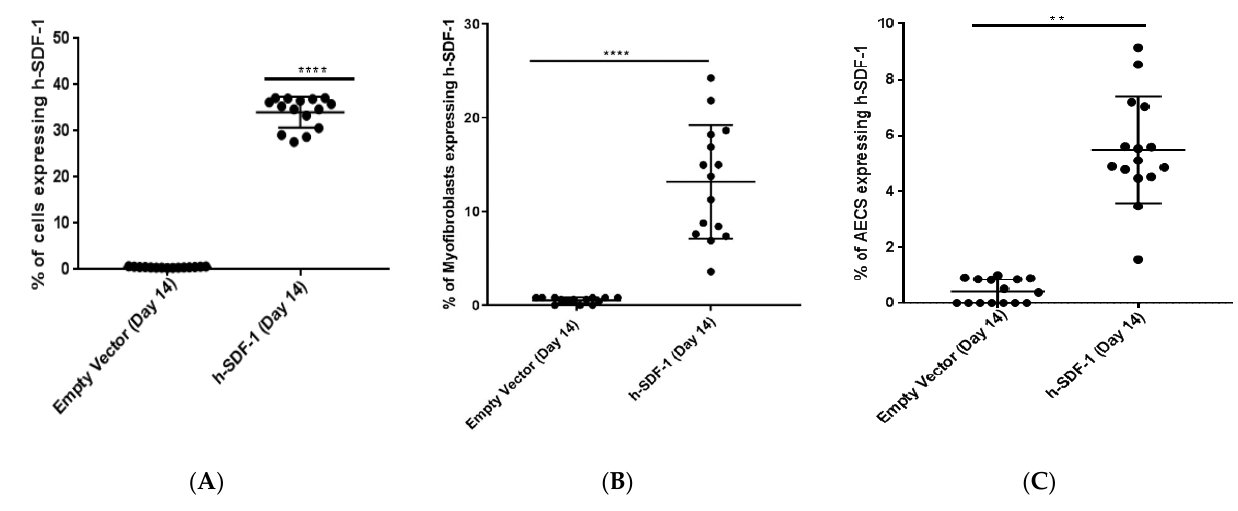
Figure 1. Efficiency of electroporation-mediated h-SDF-1 β gene transfer . In vivo electroporation- mediated pSDF-1 gene transfer to bleomycin-injured rat lung is efficient. Total percentage of rat lung cells expressing hSDF-1 ( A ); percentage of, myofibroblasts ( B ), and alveolar epithelial cells (AEC) ( C ) expressing hSDF-1 seven days after pSDF-1 gene transfer. ( n = 15); Mean ± SD; **: p < 0.01, ****: p < 0.0001).